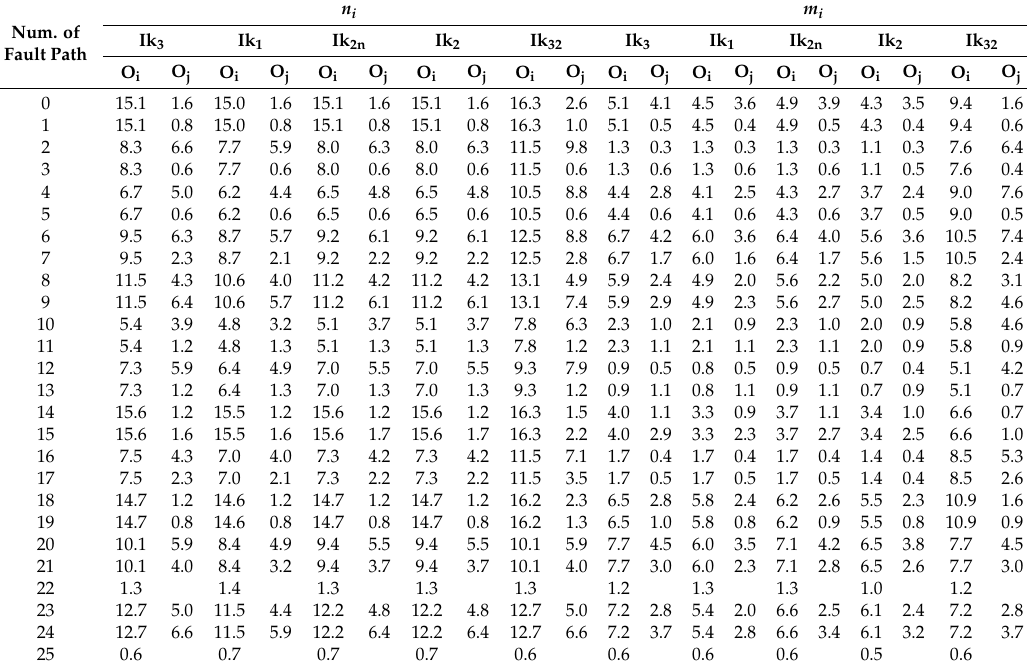
Table 7. IEEE 6-bus power system maximum short-circuit contributions (all values in kA).